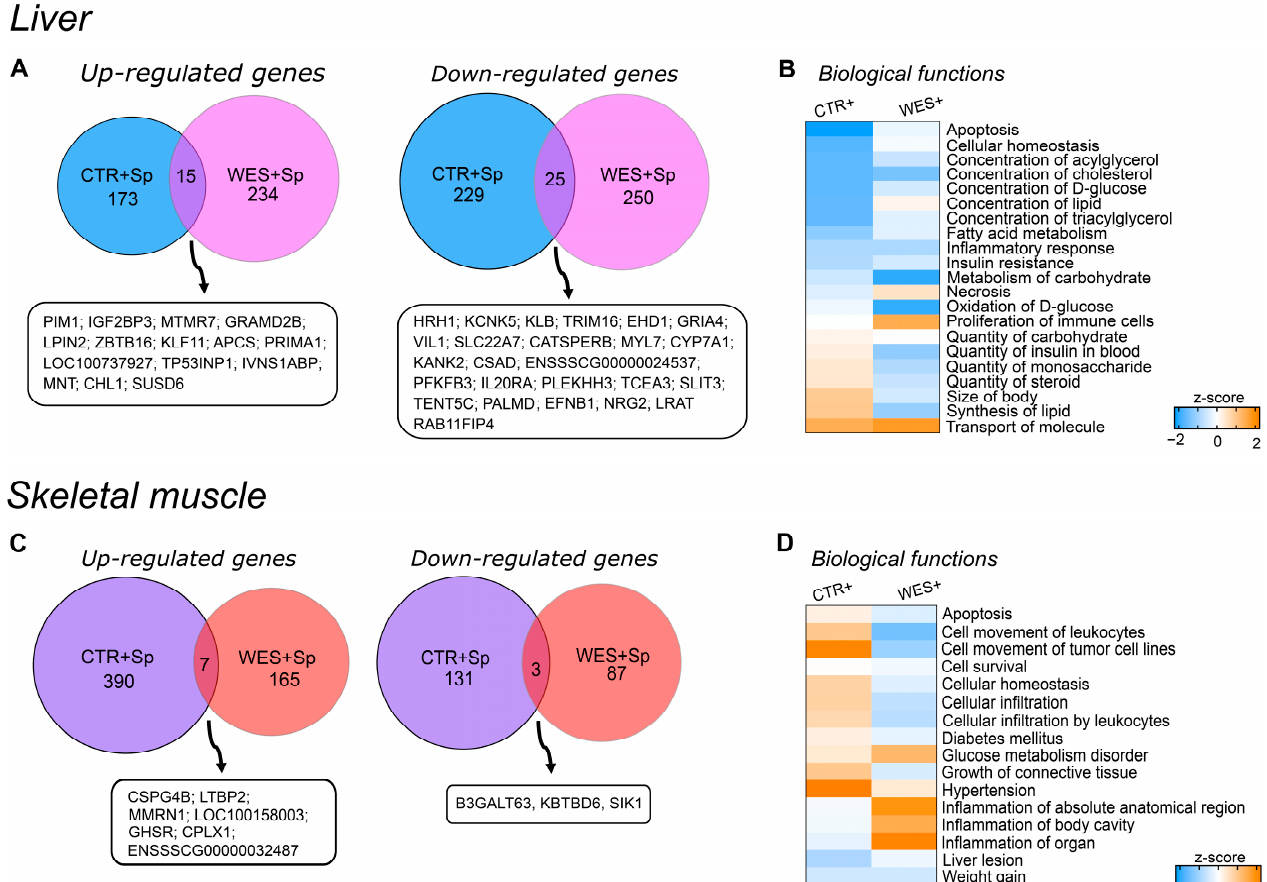
Figure 4. Effects of Sp supplementation on gene expression of liver and muscle at slaughter. ( A ) Venn diagram showing the intersection of differentially abundant transcripts in CTR+ and WES+ livers. Venn diagrams were designed using http://bioinformatics.psb.ugent.be/webtools/Venn/ (ac- cessed on 1 September 2021). ( B ) Heatmap representing the z-score of biological functions signifi- cantly affected in both CTR+ and WES+ groups (calculation performed in IPA) in the liver. Blue indicates a negative z-score (inhibition) and orange a positive z-score (activation). ( C ) Venn diagram showing the intersection of differentially abundant transcripts in CTR+ and WES+ muscle. ( D ) groups (calculation performed in IPA) in muscle.